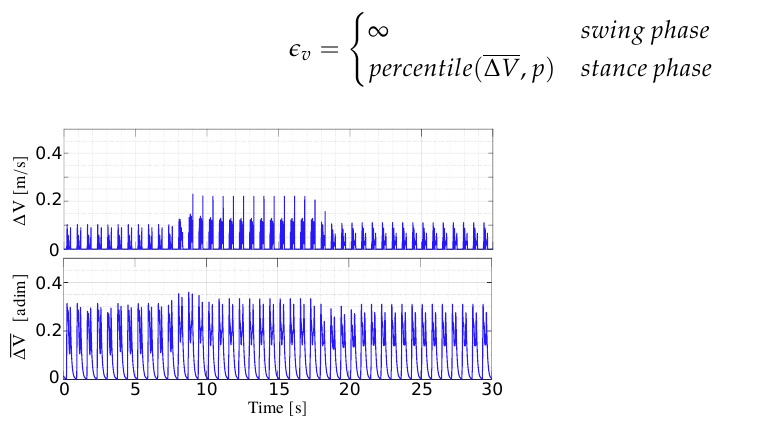
Figure 3. ∆ V ( top ) and ∆ V ( bottom ) in a simple trotting task with variable feed rate (no slippage). The higher peaks in the top-figure correspond to a higher linear velocity along the x